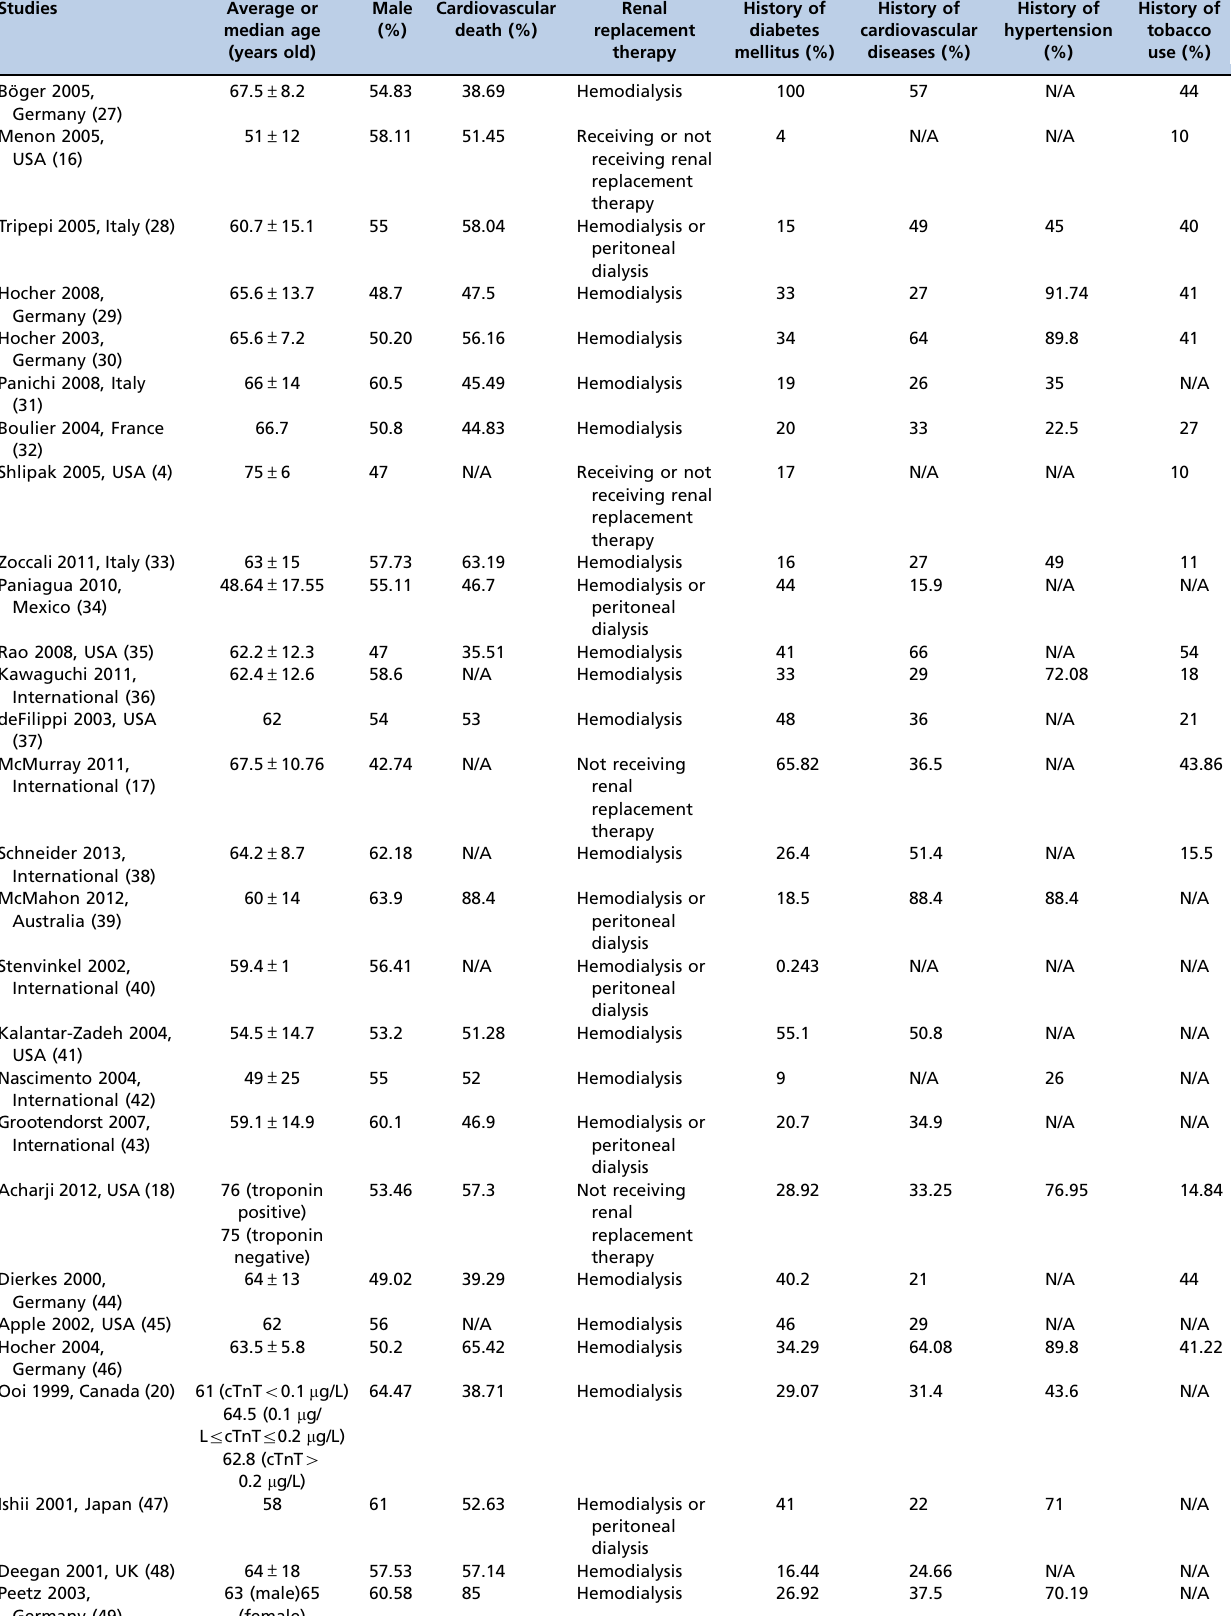
Table 2 - Patient characteristics in included